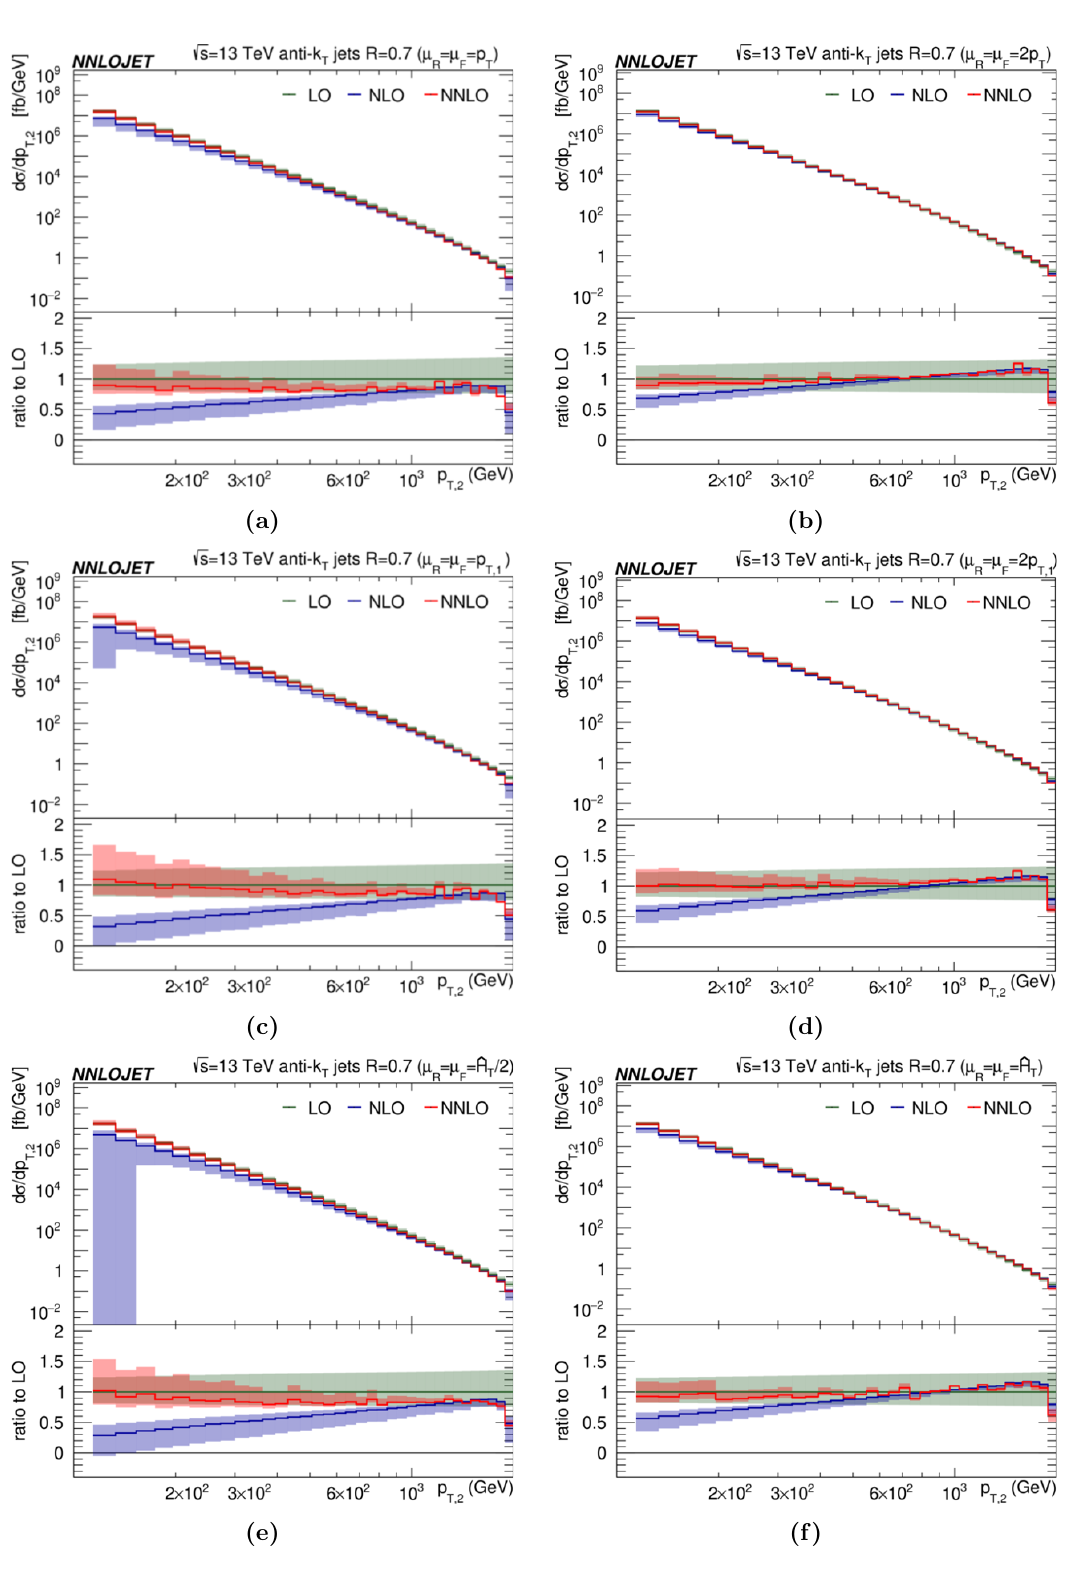
Figure 15 . The transverse-momentum distribution of the subleading jet with R = 0 : 7 for (a) (cid:22) = p T , (b) (cid:22) = 2 p T , (c) (cid:22) = p T ; 1 , (d) (cid:22) = 2 p T ; 1 , (e) (cid:22) = ^ H T = 2, (f) (cid:22) = ^ H T